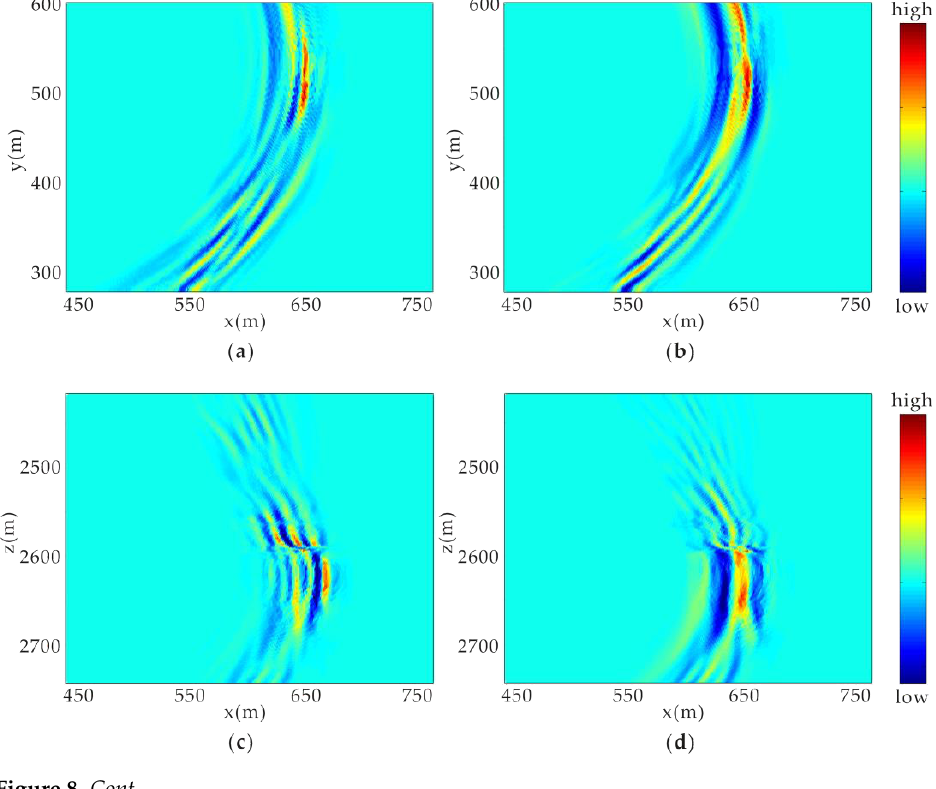
Figure 8. Waveform stacking function distribution for one of the identified microseismic events through applying the conventional and improved polarity correction methods. The horizontal slice of the waveform stacking function estimated in the xy -plane using ( a ) the conventional polar- ity correction method and ( b ) the improved polarity correction method. The vertical slice of waveform stacking function estimated in the xz -plane using ( c ) the conventional polarity correc- tion method and ( d ) the improved polarity correction method. The vertical slice of waveform stacking function estimated in yz -plane using ( e ) the conventional polarity correction method and ( f ) the improved polarity correction method. The color scale denotes the waveform stacking func- tion value (low values in blue and high values in red). The spot with the maximum value indicates the most likely position of the located event.